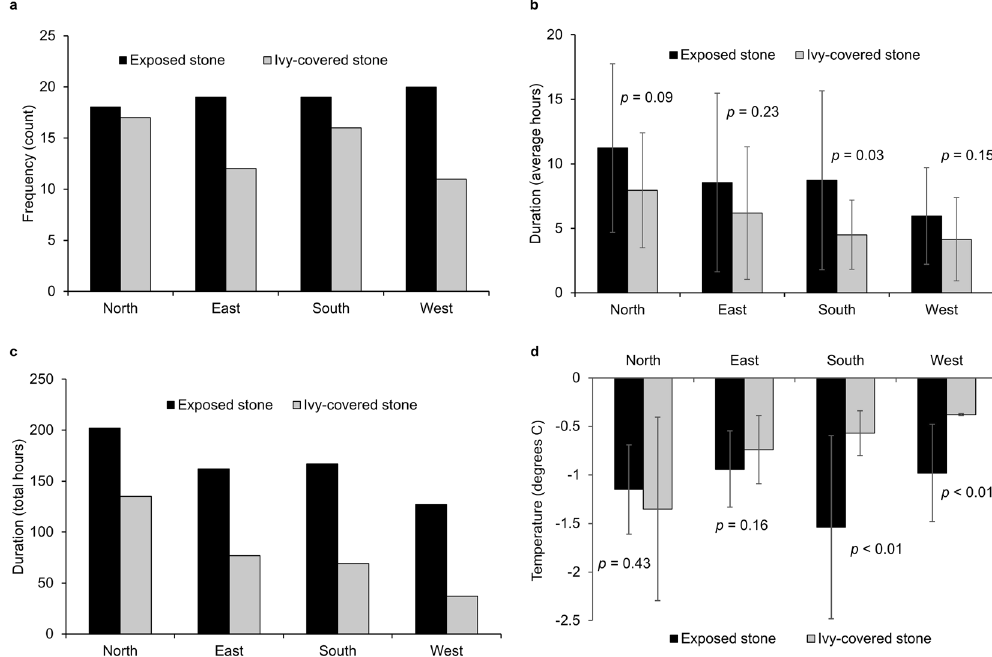
Figure 1. Frost ( a ) frequency, ( b ) duration, mean ± SD, ( c ) total frozen hours, and ( d ) severity, mean ± SD, on exposed and ivy covered sections of north-, east-, south- and west- facing test walls (winter 2012/13 and 2013/14), Wytham Woods, Oxfordshire. Significance of t-test comparisons between exposed and ivy covered sections of wall are shown for duration ( b ) and severity ( d ) of all recorded events.